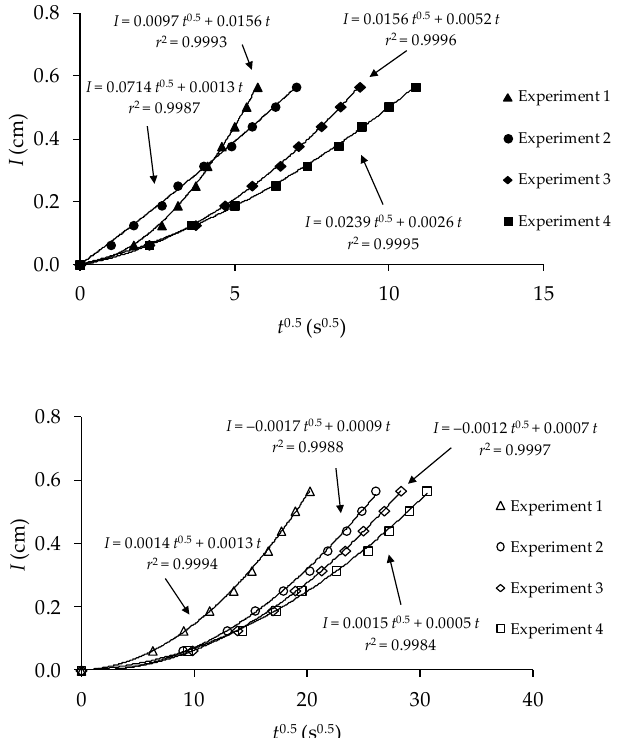
Figure 6. The early cumulative infiltration dependence on the square root of time, and the regression models (Equation (1)) fitted to four infiltration measurements at the V1 vineyard site ( upper ) and TF afforested site ( lower ).